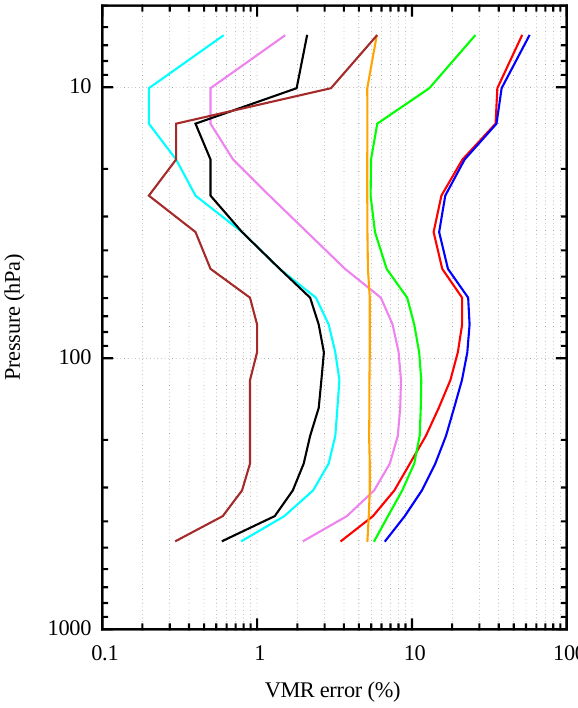
Figure 2. Error analysis of the joint COCl 2 and CFC-11 retrieval: the total error (blue), the total systematic error (green) and the total random error (red). We also report the uncertainties due to temper- ature (violet), pressure (cyan), spectroscopic database (orange-red), intensity calibration (black) and to the width of the instrument line shape (brown) for the phosgene